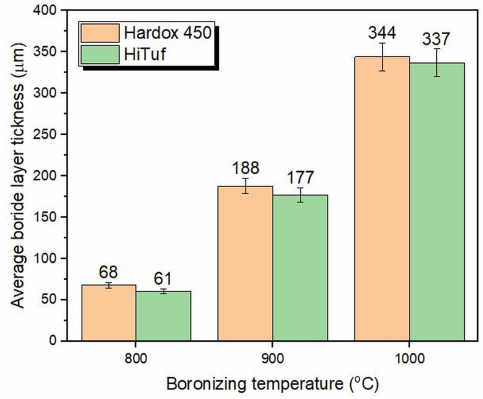
Figure 2: The effect of boriding temperature on boride layer depth in Hardox 450 and HiTuf steels.